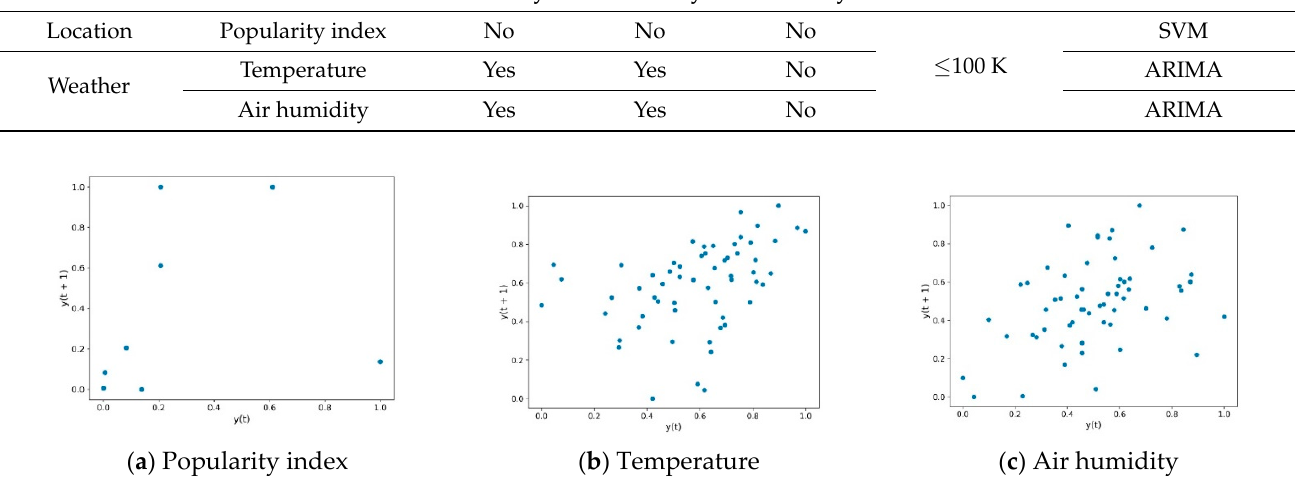
Figure 10. Scatter plot for popularity index, temperature, and air humidity. Table 12. Data characteristics tests and results.